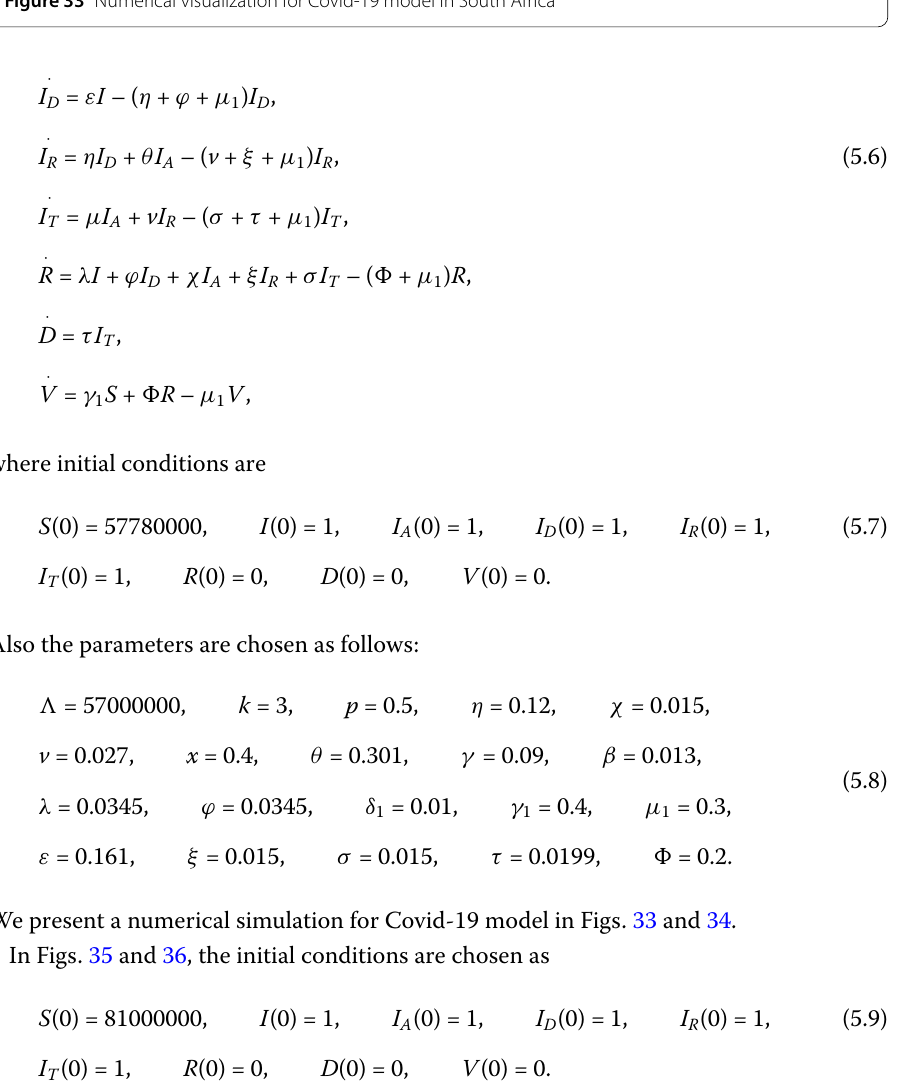
Figure 33 Numerical visualization for Covid-19 model in South